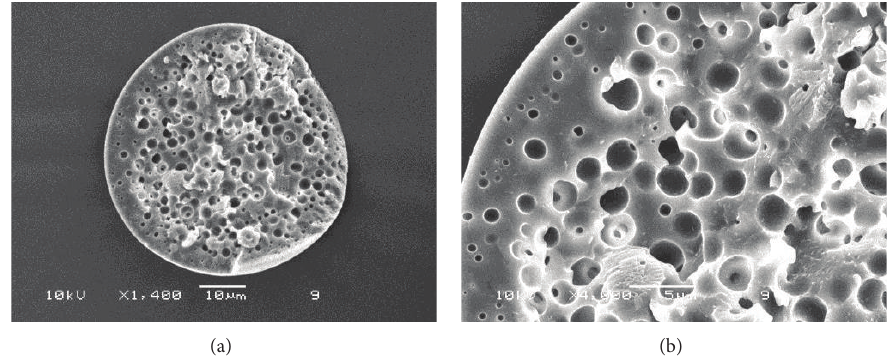
Figure 3: Internal morphology of broken drug-loaded 35/65 (w/w) starch/gelatin blend microparticles crosslinked with 25 g glutaraldehyde/100 g starch/gelatin with magnifications of (a) × 1,400 and (b) × 4,000. (Bars = 10 and 5 𝜇 m for (a) and (b) images, resp.)